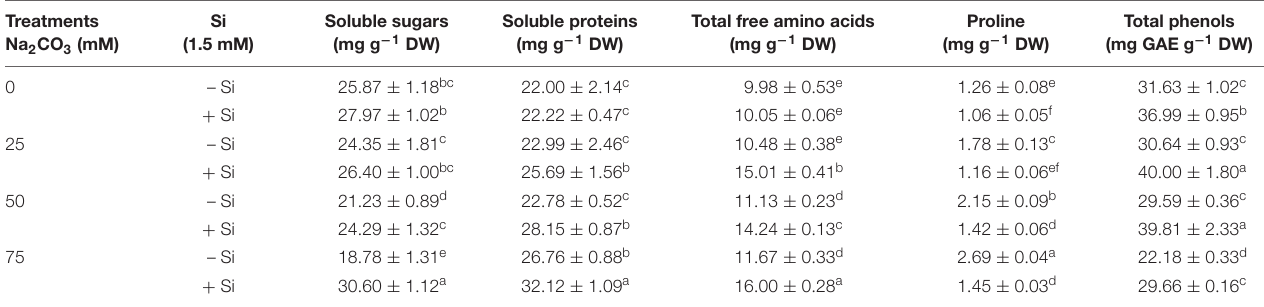
TABLE 2 | Effects of different levels of alkaline stress with and without seed-priming with silicon (Si) on the contents of soluble sugars, soluble proteins, total free amino acids, proline, and total phenols in 25-day-old maize plants. Treatments Na 2 CO 3 (mM)